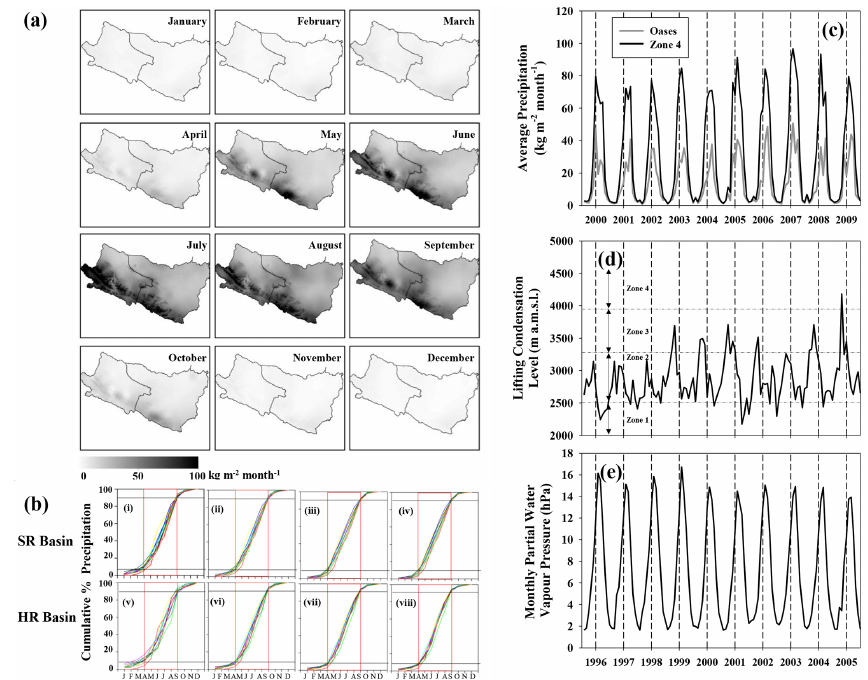
Figure 6. Ten-year average distribution and time series of monthly precipitation (kgm − 2 month − 1 ) according to time of year (a, c) and spatially averaged cumulative curves of % precipitation over the course of individual years for 2000–2009 (b) . Letters along the x axis of plots in (b) coincide with month, January (J) through to December (D). Vertical red lines denote the approximate time of the onset (first line) and cessation of the precipitation season (second line) in the Shiyang (SR Basin; i – iv ) and Hei river basins (HR Basin; v – vii ), respectively. Plots (i) through (iv) and (v) through (vii) represent the cumulative % precipitation in the two river basins for zone 1 through zone 4. Panels (d) and (e) give the monthly mean lifting condensation level (LCL) and actual water vapour content of air at the base of the Qilian Mountains (i.e. Wuwei City; Table 1) over a different 10-year period (1996–2005). Values of LCL are calculated from ( T dry − T dew )/((cid:48) dry − (cid:48) dew ) × 1000m + elevation at base of Qilian Mountains (i.e. 1534m at Wuwei City), where T dry and T dew are the monthly surface dry-bulb and dew-point temperature (both in ◦ C), and (cid:48) dry and (cid:48) dew are the dry adiabatic and dew-point temperature lapse rates, ∼ 10 vs. ∼ 2 ◦ C per 1000m, respectively (Warner, 2004; Aguado and Burt, 2013). Vertical dashed lines in (c) to (e) represent the middle of the